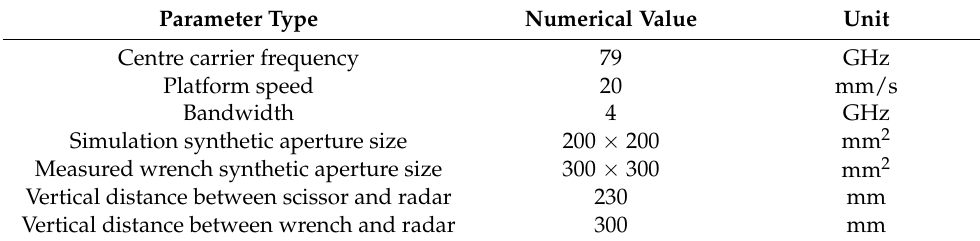
Table 2. The parameters of the SAR platform.